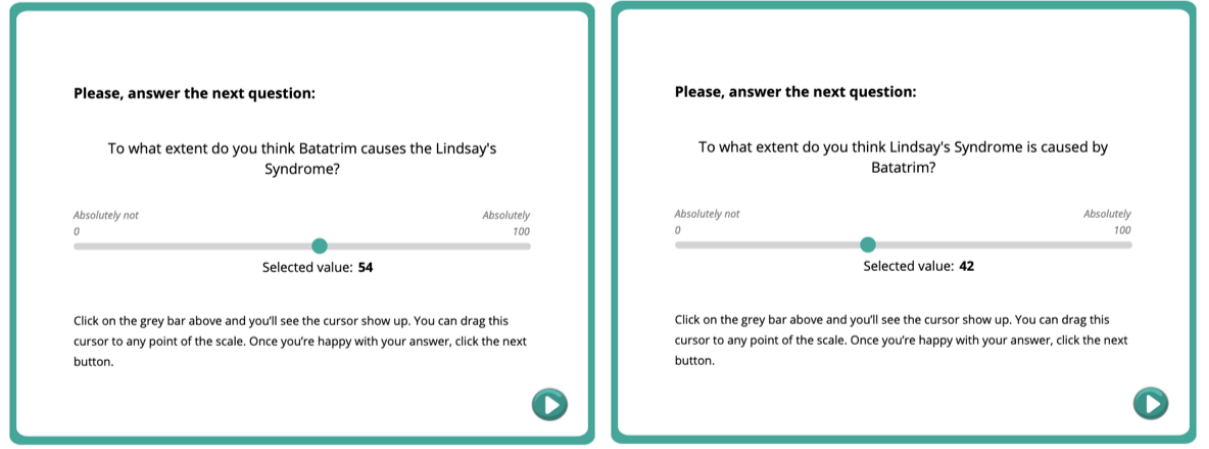
Figure 3. The final screen where the causal relation between Batatrim and Lindsay syndrome is assessed. The question is shown worded as cause-to-effect (left) or effect-to-cause